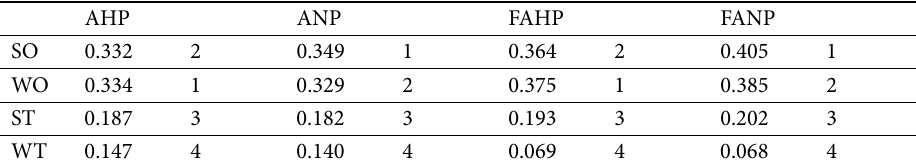
Table 15. Weights and ranking of the alternative strategies for the four methodologies AHP ANP FAHP FANP SO 0.332 2 0.349 1 0.364 2 0.405 1 WO 0.334 1 0.329 0.375 0.385 ST 0.202 WT 0.147 4 0.140 0.069